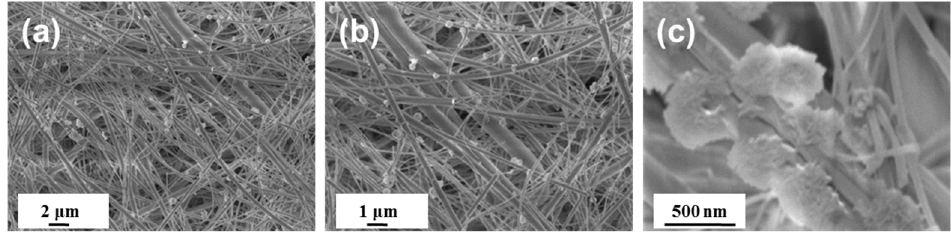
Figure A1. SEM images of a low ‐ crystalline zinc oxide substrate at different resolutions ( a ) 2 μ m, ( b ) 1 μ m, ( c ) 500 nm.